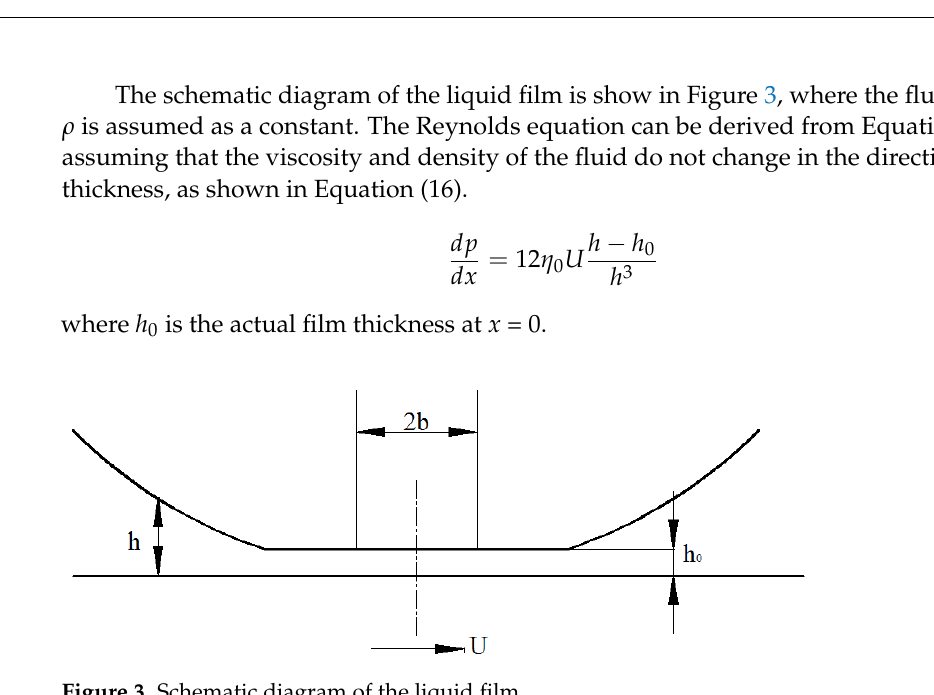
Figure 3. Schematic diagram of the liquid